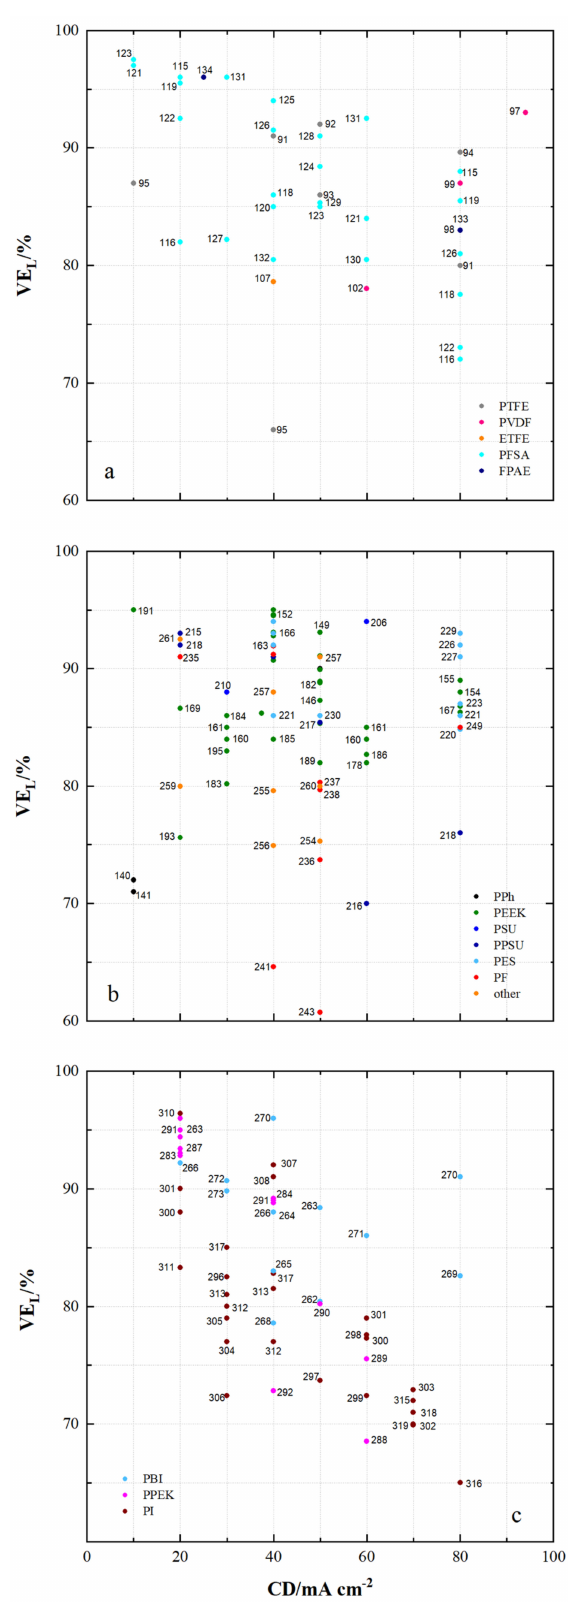
Figure 10. The voltage efficiency of VRFB cells by using membrane samples at current densities < 100 mA cm − 2 : ( a ) fluoro-carbons, ( b ) hydro-carbons and ( c ) N